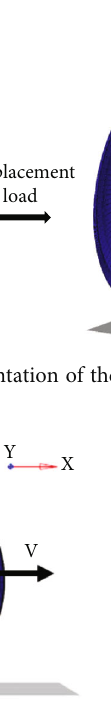
Table 6: Conditions for orthogonal tire